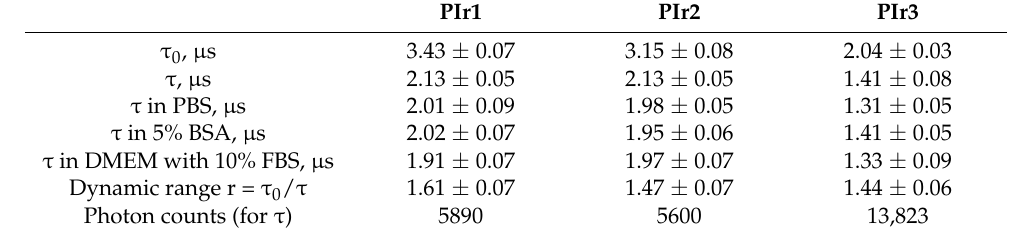
Table 3. Phosphorescence lifetimes of PIr1–PIr3 probes in degassed ( τ 0 ) and aerated ( τ ) aqueous solutions at room temperature. λ ex = 375 nm.